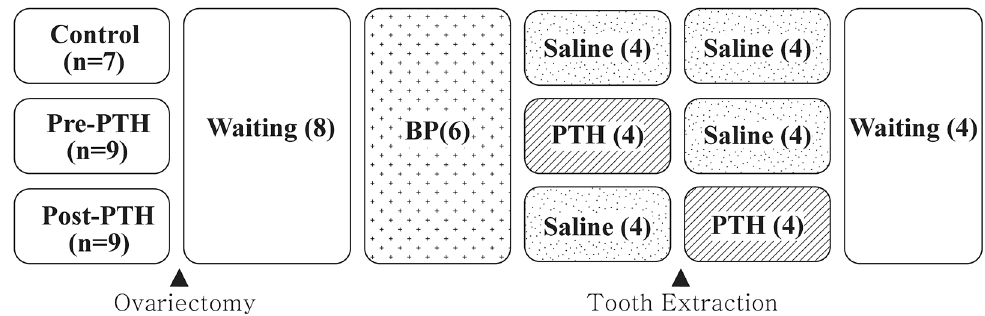
Figure 3. Experimental design. Rats (n = 25) underwent ovariectomy, followed by an 8-week waiting period. Zoledronic acid (200 μg/kg) was administered for 6 weeks. Before or after tooth extraction, 80 μg/kg of saline or parathyroid hormone (PTH) was administered daily, depending on the group. The parentheses refer to the period (weeks) taken for the experiments. BP